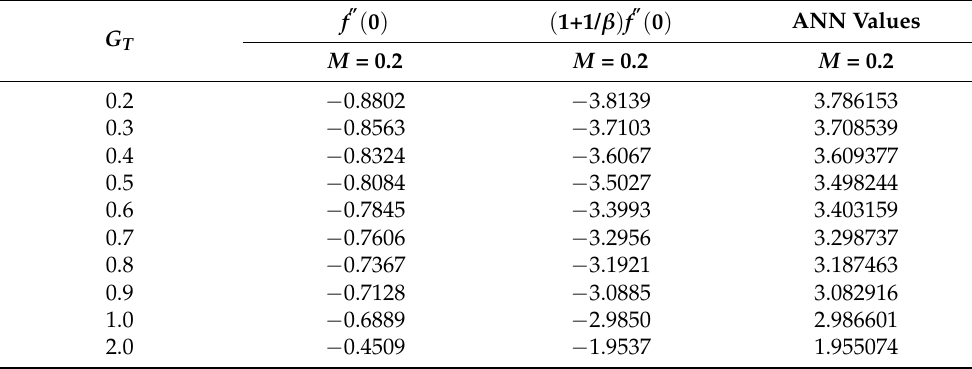
Table 8. Impact of the temperature Grashof number on the SFC for the magnetic flow